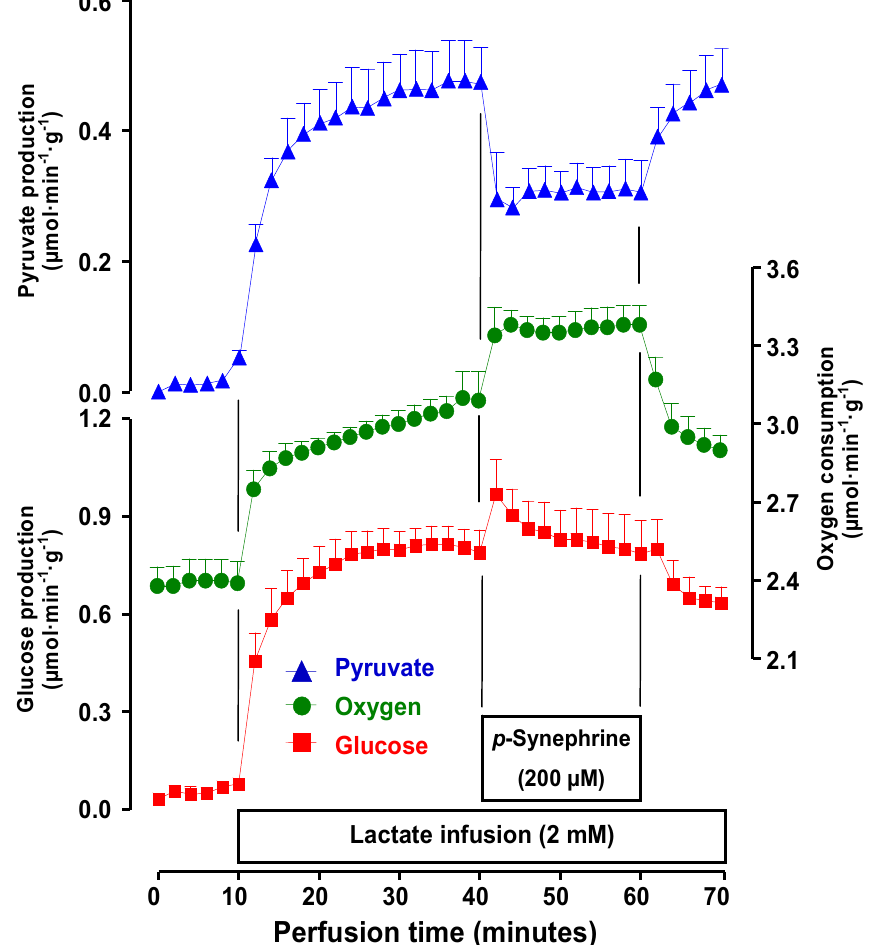
Figure 8. Effects of p -synephrine on lactate gluconeogenesis and related parameters in perfused livers from fasted rats. Livers from fasted rats were perfused as described in the Experimental Section. Lactate (2 mM) and p -synephrine were infused as indicated by the horizontal